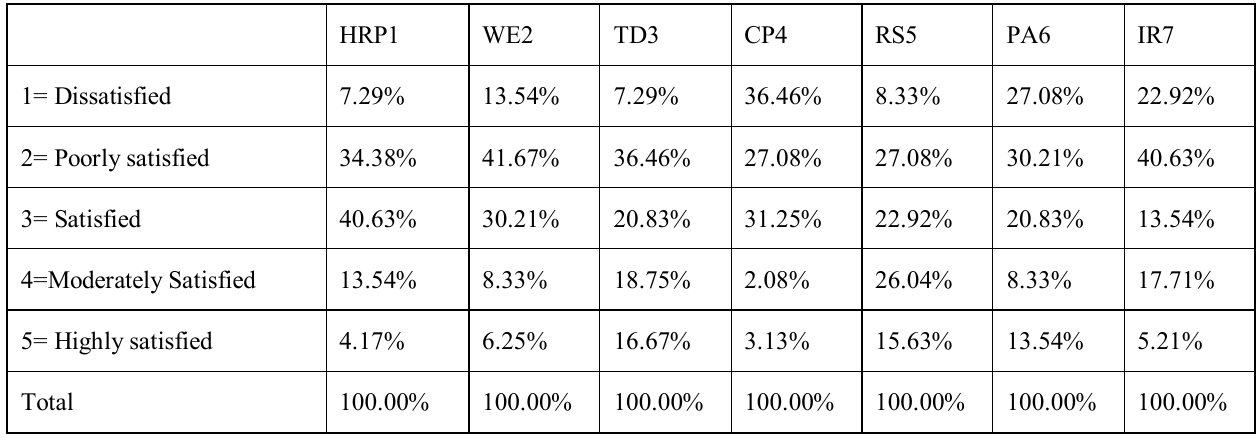
4=Moderately Satisfied 13.54% 4.17% Total 100.00% 100.00% 100.00% 100.00% 100.00% 100.00%